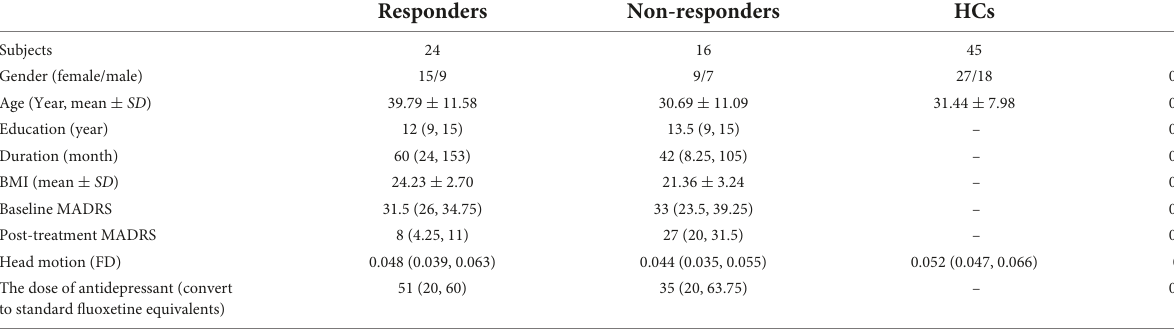
TABLE 1 Demographics and clinical characteristics of the MDD and HCs at